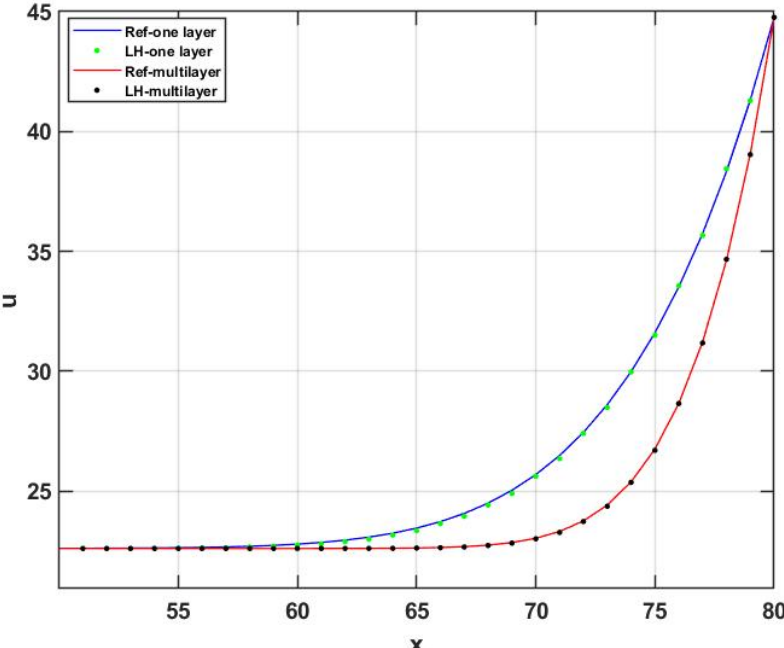
Figure 20. The temperature as a function of the cell index in the x direction at the middle row ( z ≈ 0.5 ) in the case of the reference solution (Ref) and the leapfrog-hopscotch (LH) method for ∆ t = 400 in the case of the one-layer wall and the insulated wall using an equidistant grid.